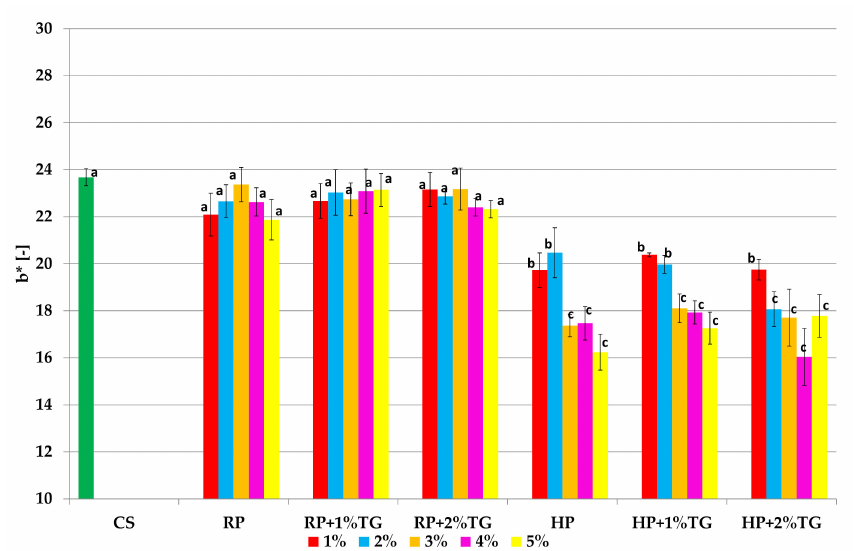
Figure 5. Average values of the b* parameter of instant noodles with the addition of rice